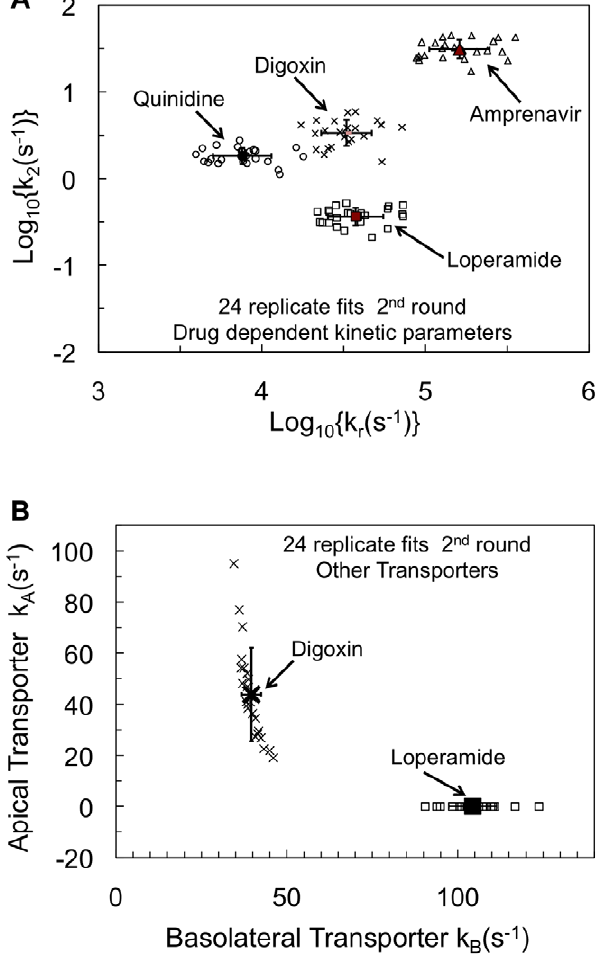
Figure 4. 24 independent replicate fits from the 2 nd fitting round for drug dependent kinetic parameters. Fig. 4A shows the fitted values for k r and k 2 for each drug. The x- and y-axes show the upper and lower bounds for these fits. Like Fig. 3, the open symbols show the 24 individual fits for amprenavir (AMP, triangles), quinidine (QND, circles) and loperamide (LPM, squares) and digoxin (DGX, x). The closed symbols show the log-average with error bars showing standard deviations. Fig. 4B shows the fitted values for the loperamide basolateral transporter, k B , (LPM, squares) and for the digoxin basolateral and apical transporters, k B and k A , (DGX, x symbols). The closed symbols show the log-average with error bars showing standard deviations. The x- and y-axes show the upper and lower bounds for these parameters. The consensus average values, standard deviations and the ranges are given in Table